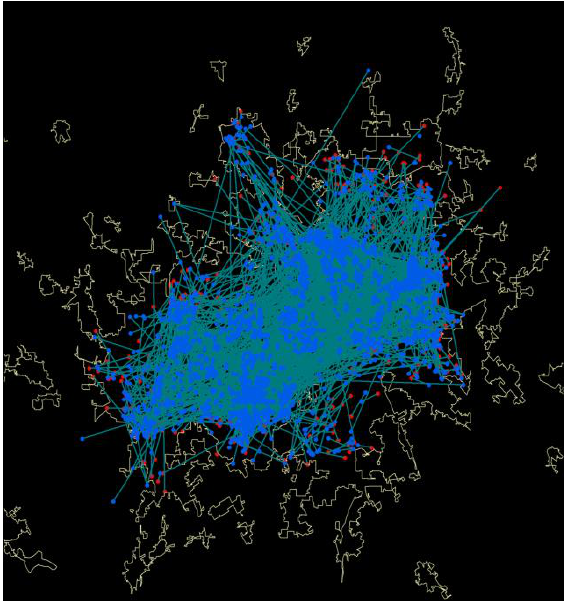
Figure 5. Austin metropolitan area